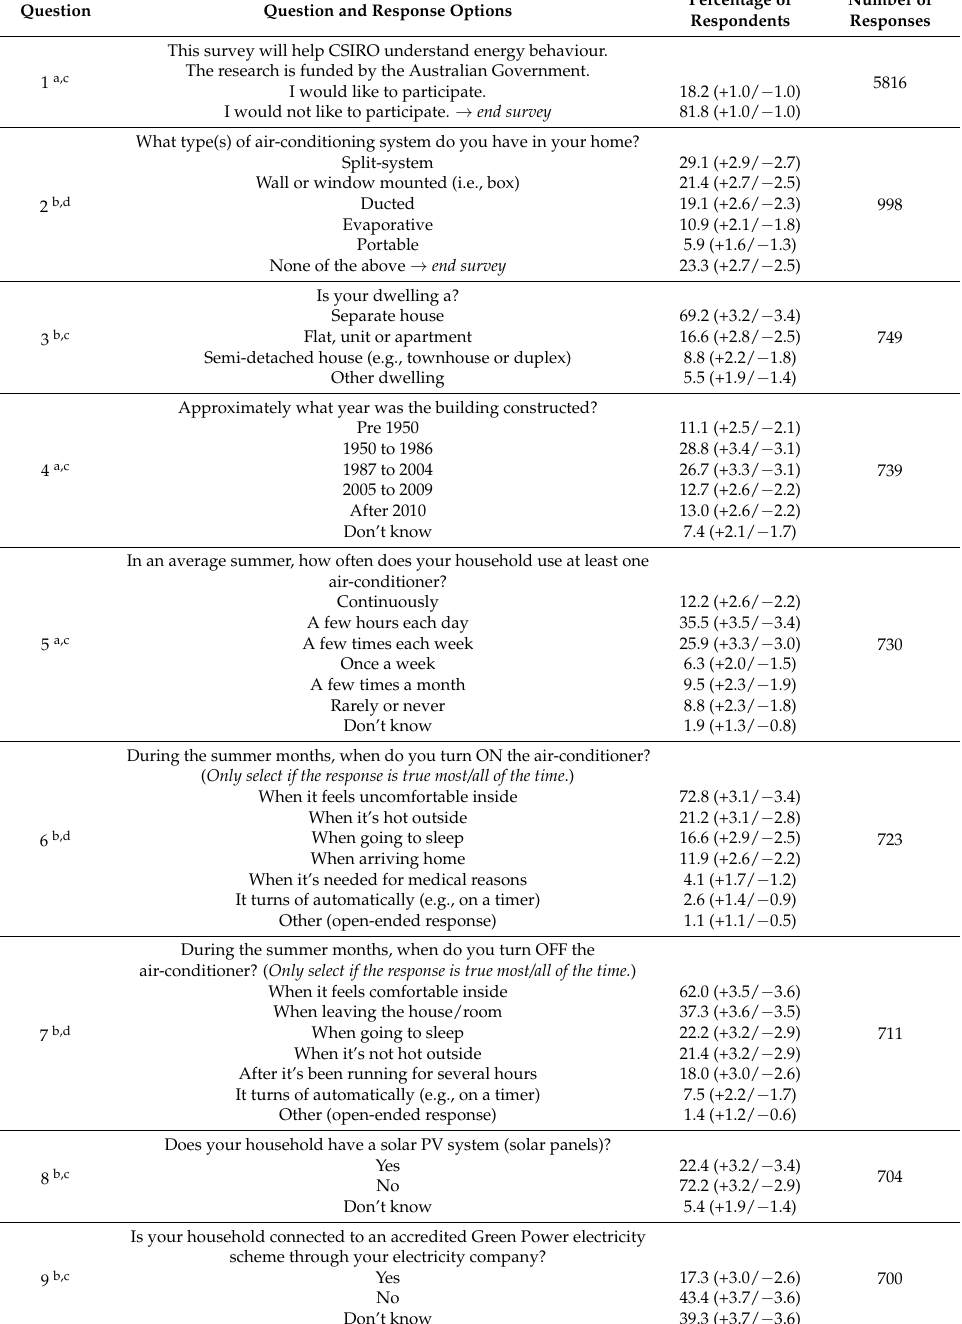
Table A1. Survey questions and response